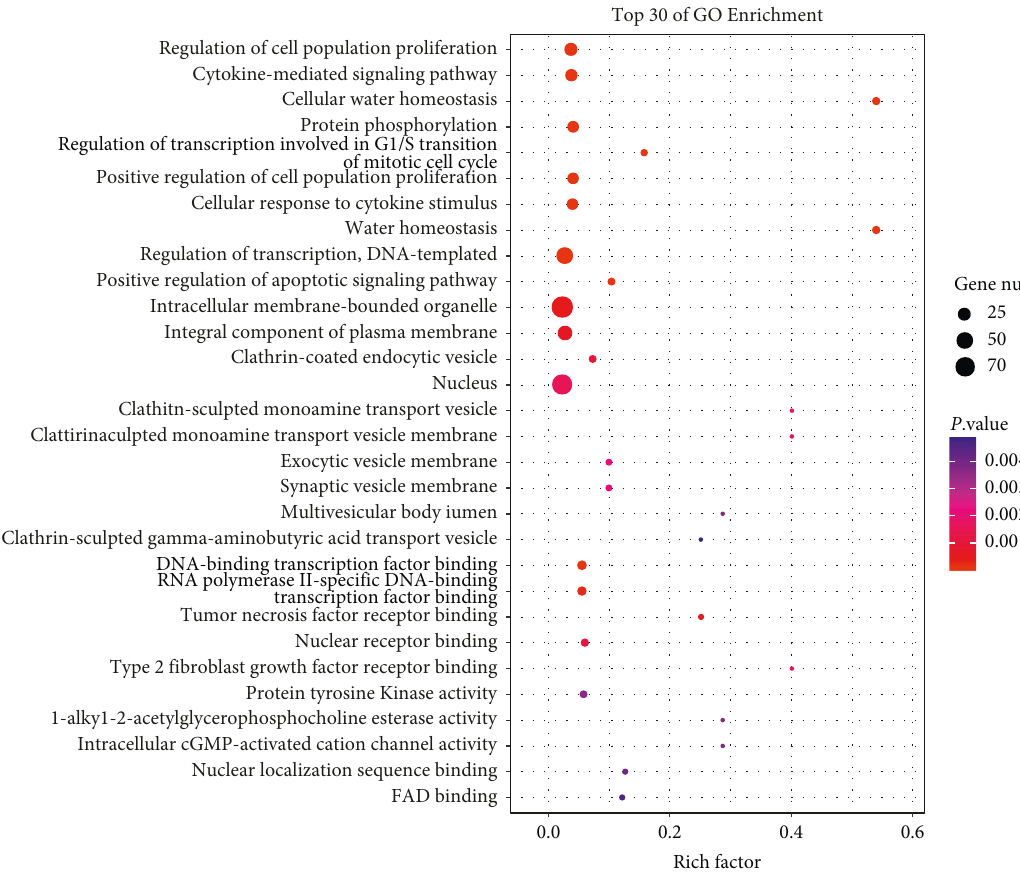
Figure 4: Scatter plot of GO function enrichment results. The top 30 functions of DEG enrichment in